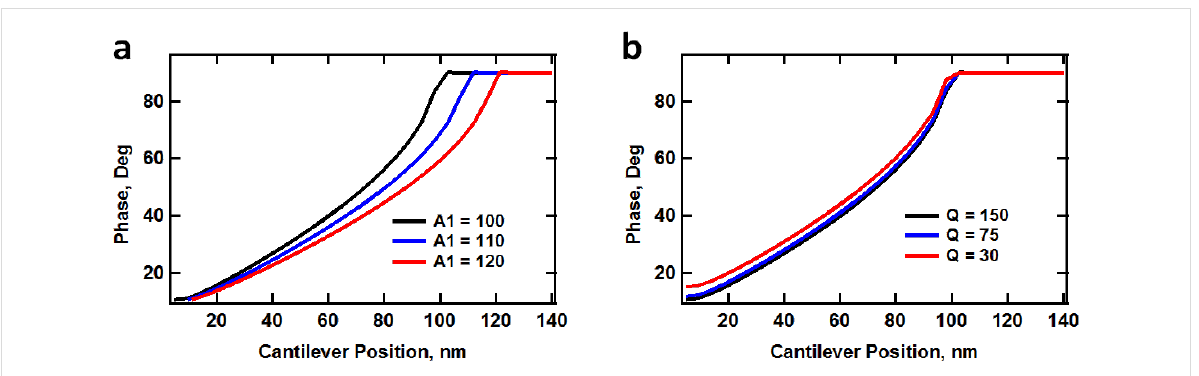
Figure 5: Simulated behavior of the first eigenmode phase as a function of free amplitude (a) and cantilever quality factor (b). See Figure 2 for the corresponding behavior of the indentation.